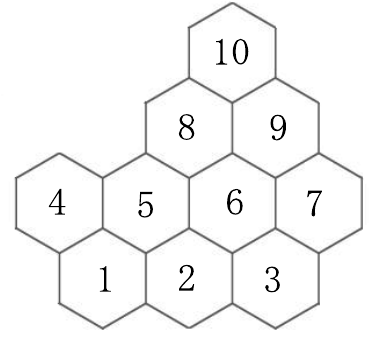
Figure 6. An example of a board of size 10 and given numbers to its places.